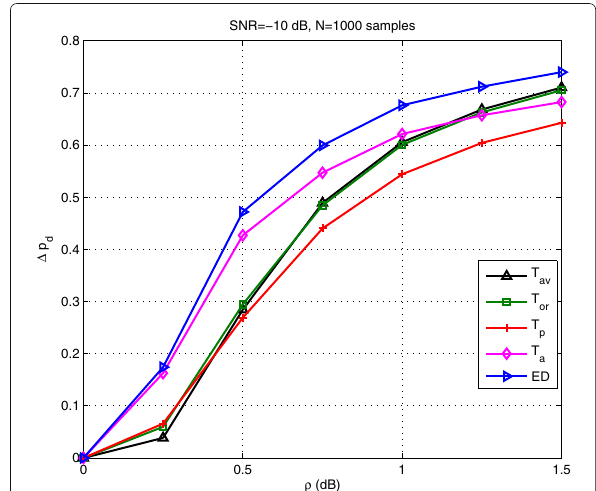
Fig. 10 Evolution of p fa in terms of the NU ( ρ ) for ED and the proposed detectors